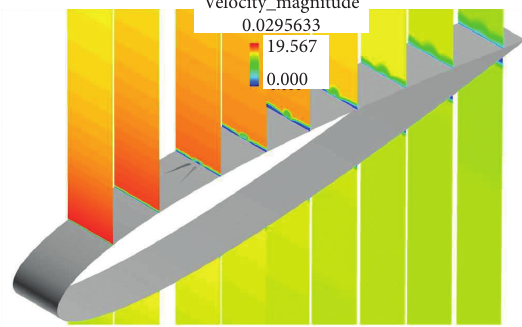
Figure 14. Perspective view of the transverse velocity profiles on the NACA